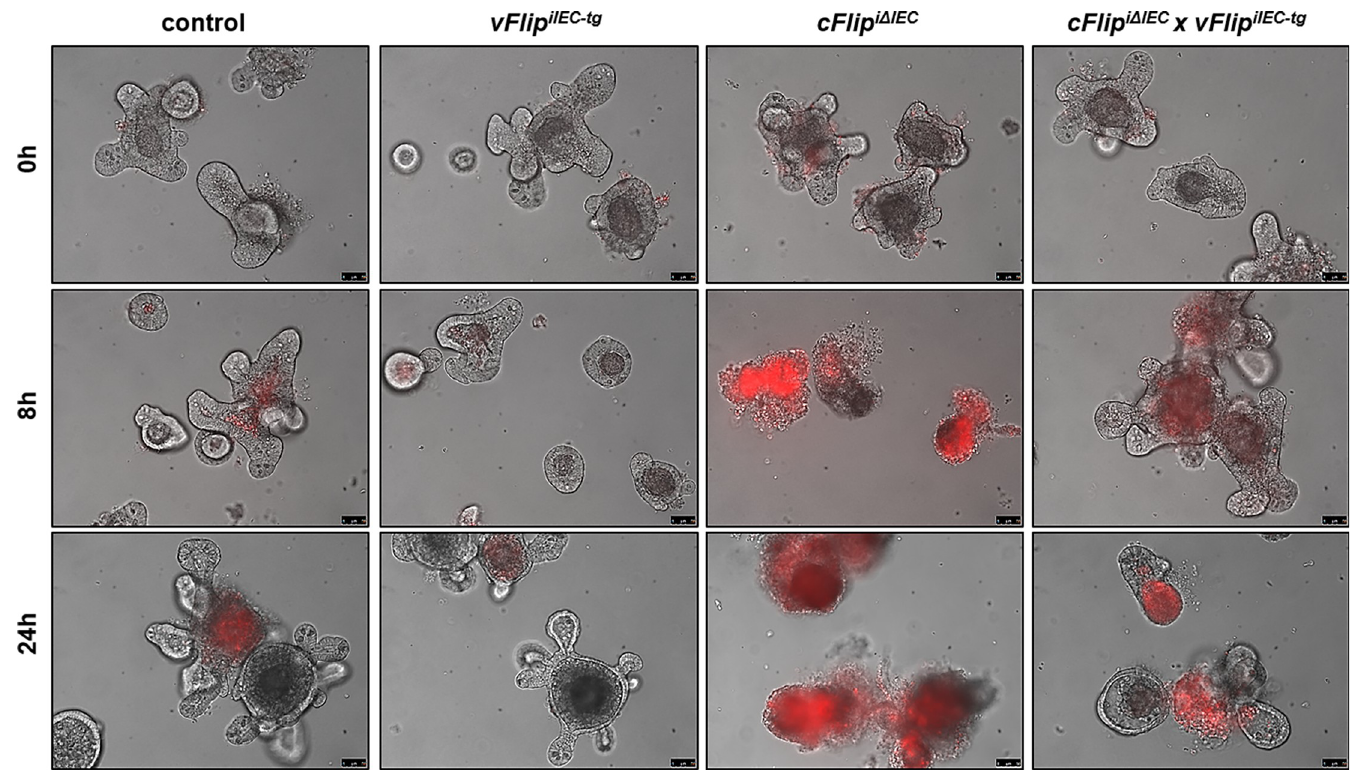
Fig 5. vFlip expression protects from TNF α induced cell death in cFlip -deficient organoids. Representative microscopic pictures (bright field) of small intestinal organoids derived from indicated mice, treated with tamoxifen (50ng/ml) for 4d and afterwards stimulated with TNF α (25ng/ml) for indicated time. Dead cells were stained with propidium iodide (red), Scale bar = 75 μ m.